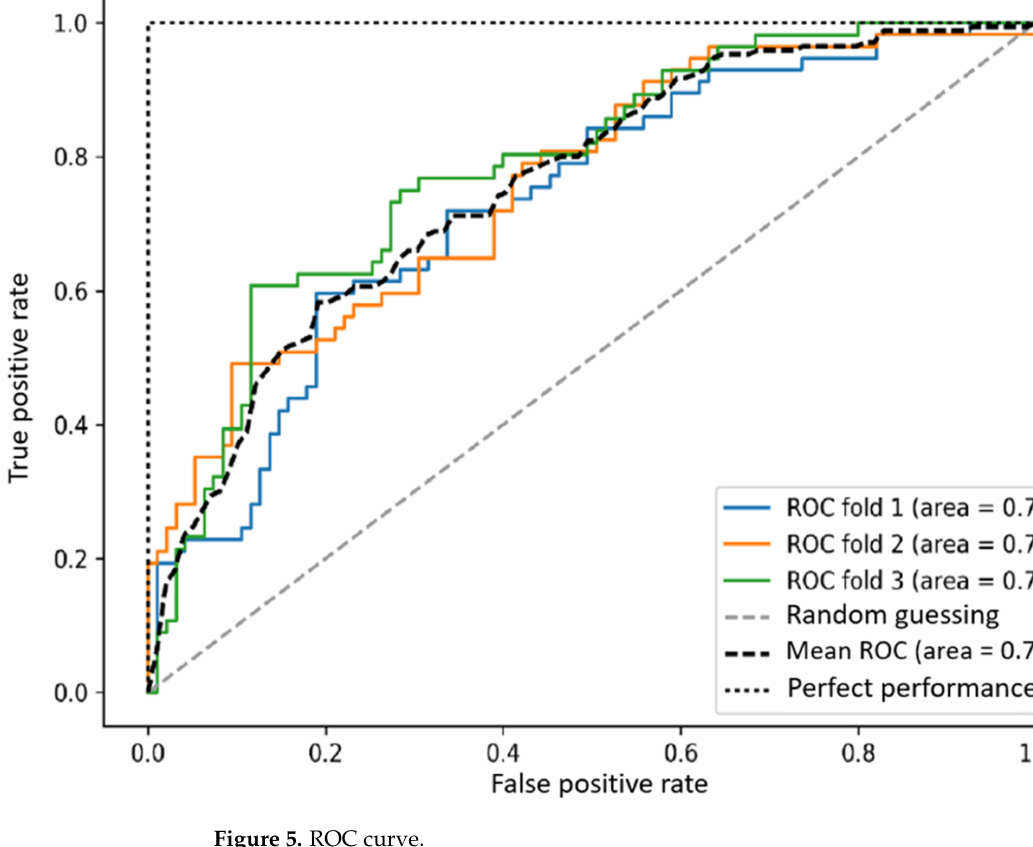
Figure 5. ROC curve.